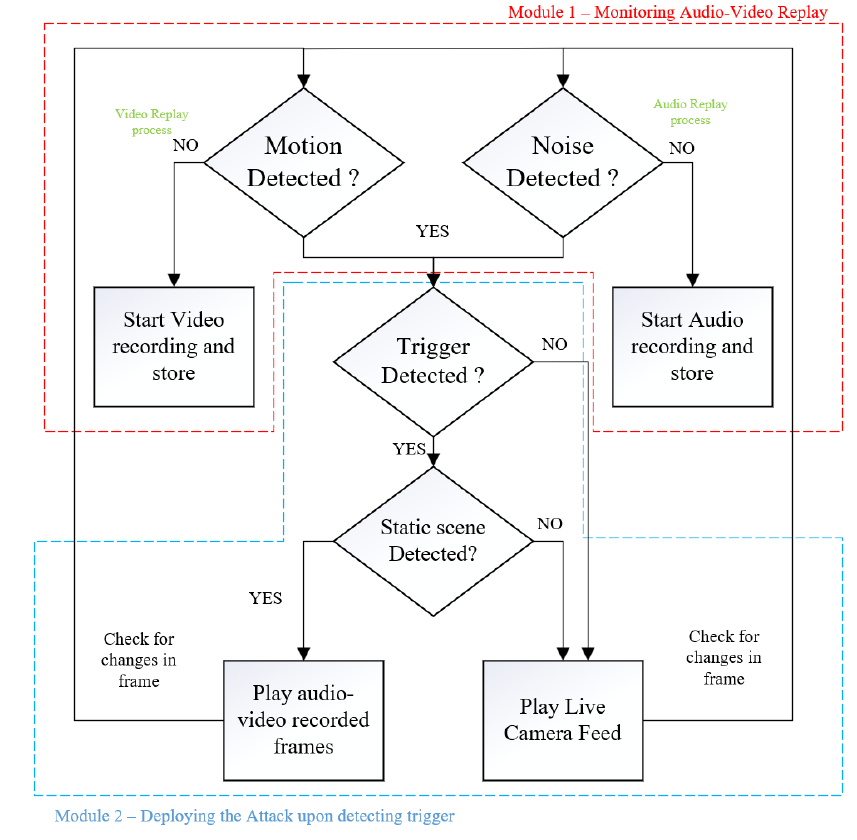
Figure 5. Flow diagram of the frame duplication